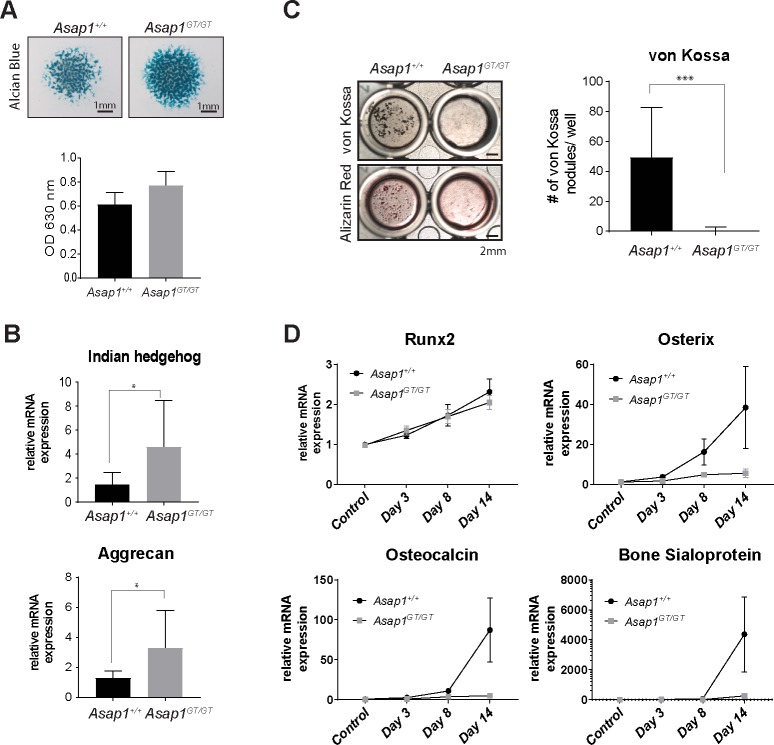
Loss of ASAP1 promotes chondrogenesis but prevents mineralization in vitro.(A) Limb bud mass cultures of Asap1+/+ and Asap1GT/GT embryos were stained with Alcian Blue after seven days of differentiation. Two representative pictures per genotype are shown (left panel). Alcian Blue was extracted and the OD measured at 630 nm. The data represent the mean ± SD (Asap1+/+ n = 18, Asap1GT/GT n = 18). Scale bars: 1 mm. Significance was calculated using the Student’s t-test (right panel). (B) qPCR analysis of limb bud mass cultures after seven days of differentiation. Relative mRNA expression was analyzed for aggrecan and Indian hedgehog, and normalized to RibP0 expression. Data represent the mean ± SD (Asap1+/+ n = 8, Asap1GT/GT n = 8). Significance was calculated using the Student’s t-test.* p< 0.05. (C) Asap1+/+and Asap1GT/GT MEFs were differentiated into the osteogenic lineage and stained for mineral deposition by von Kossa and Alizarin Red. Representative pictures of differentiated Asap1+/+ and Asap1GT/GT MEFs are shown (left panel). Quantification of von Kossa positive nodules (right panel). The graph represents the mean ± SD of three biological replicates for three independent MEF cell lines per genotype. Scale bars: 2 mm. Significance was calculated using the Student’s t-test. *** p < 0.0005 (D) Late osteogenic markers are not induced in ASAP1-deficient cells. qPCR analysis of differentiating MEFs at day 3, day 8 and day 14 and untreated control cells. Relative mRNA expression was analyzed for Runx2, ALP, osteopontin, osterix, osteocalcin and bone sialoprotein, and normalized to expression of RibP0. Data represent the mean ± SEM (Asap1+/+, n = 4 and Asap1GT/GT, n = 5).